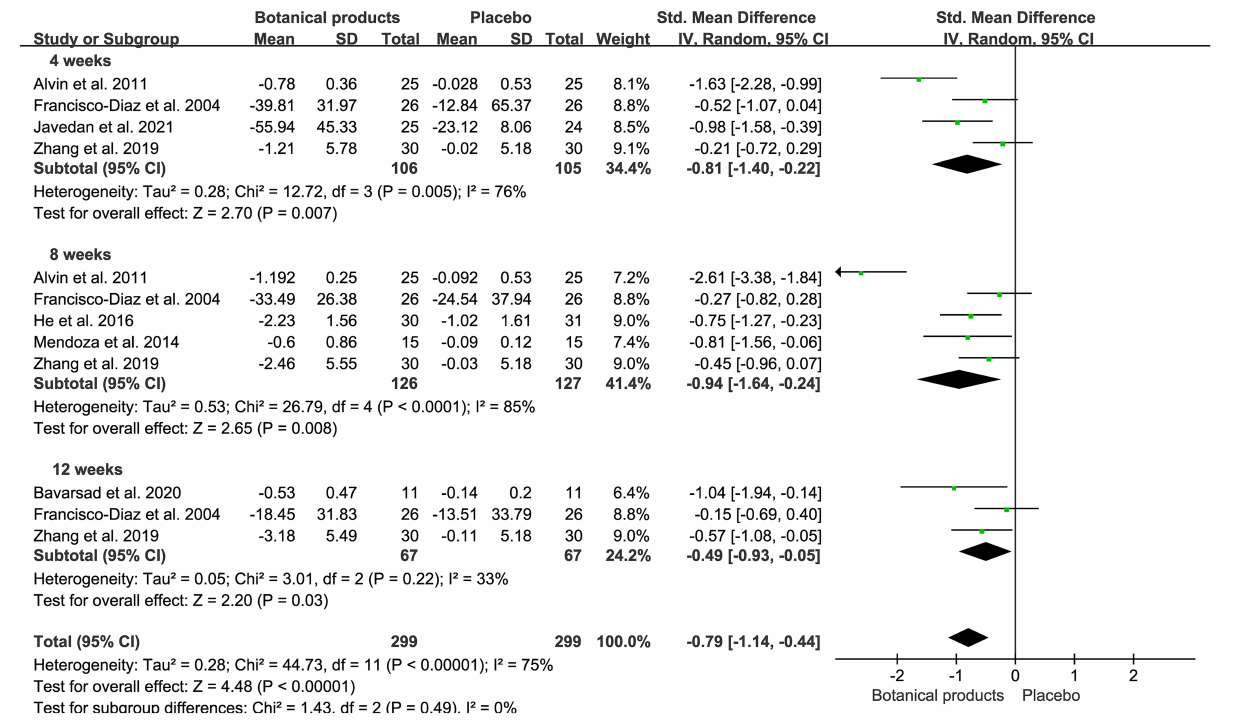
botanical products vs. actives was − 0.00 (95% CI − 0.36–0.35,